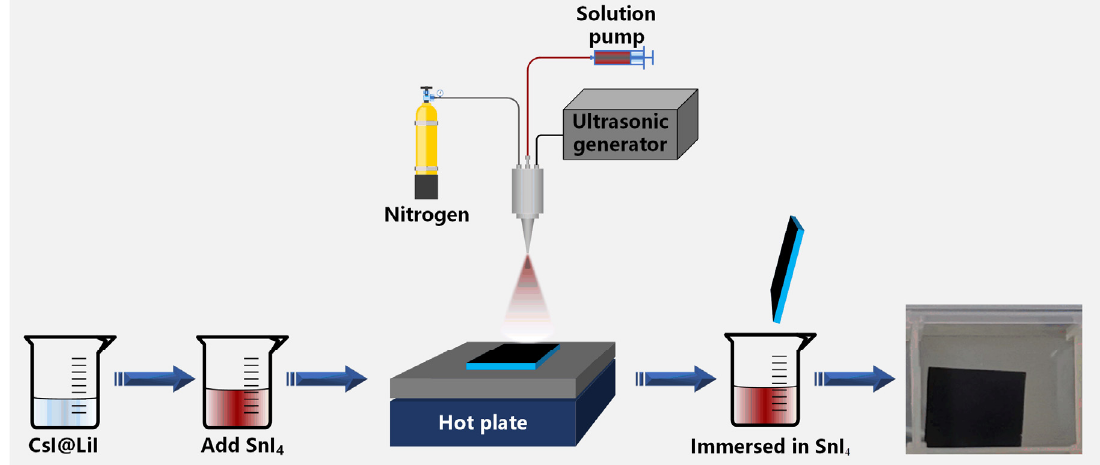
Figure 1. Schematic illustration for the preparation of Li + doped Cs 2 SnI 6 thin films.